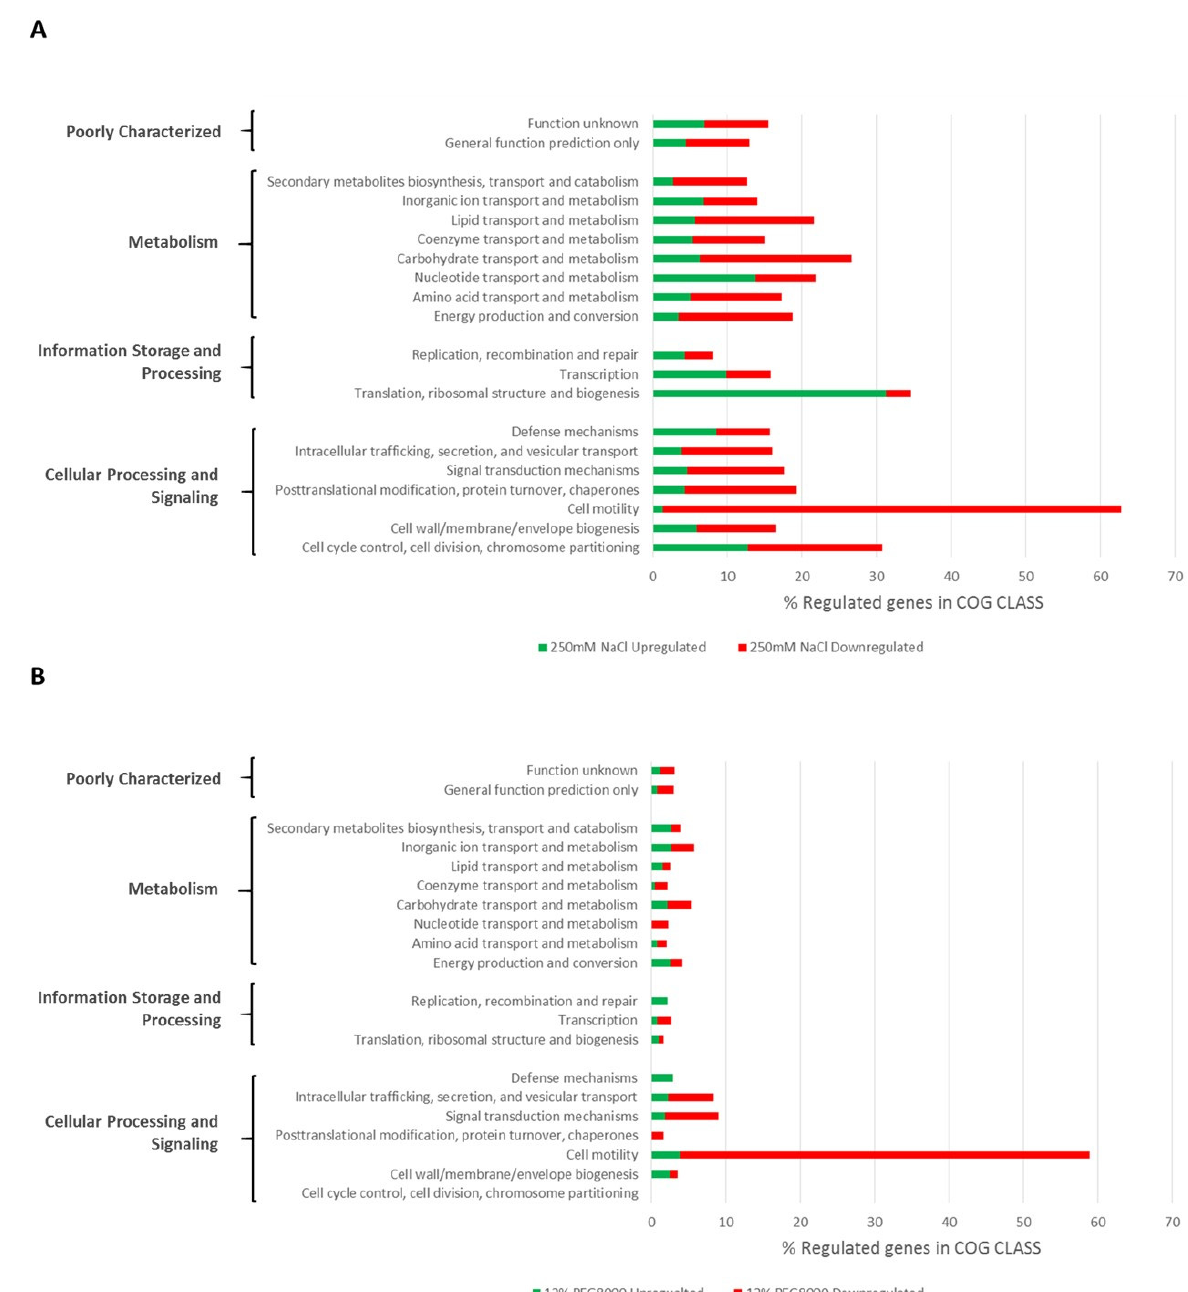
Figure 1. COG-based functional classification of genes regulated (>50 × mean coverage and a minimum of 2-fold change) upon salt ( A ) or PEG8000 ( B ) treatments. The horizontal bars represent the % of genes regulated in the corresponding COG Class and, for each bar, the relative proportion of genes that are up- or down-regulated is shown in green and red, respectively. The COG class description and processes to which they belong are shown on the left of graphs.